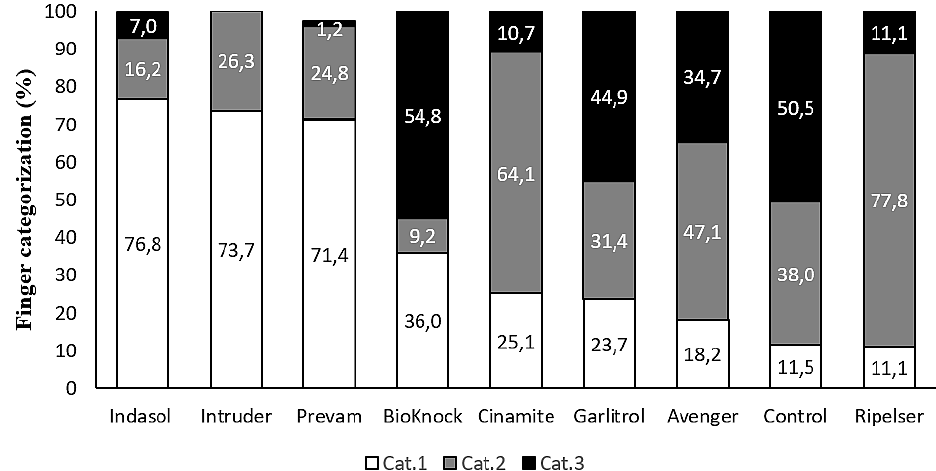
Figure 5. Damage level categorization in each treatment according to European Standards (EPPO, PP1). Cat. 1: without damage and/or the damage is <1 cm 2 at 1 finger; fulfilling European norms; Cat. 2: damage > 1 cm 2 on 1 finger, or <1 cm 2 on some fingers; Cat. 3: damage > 1 cm 2 more than 2 fingers.